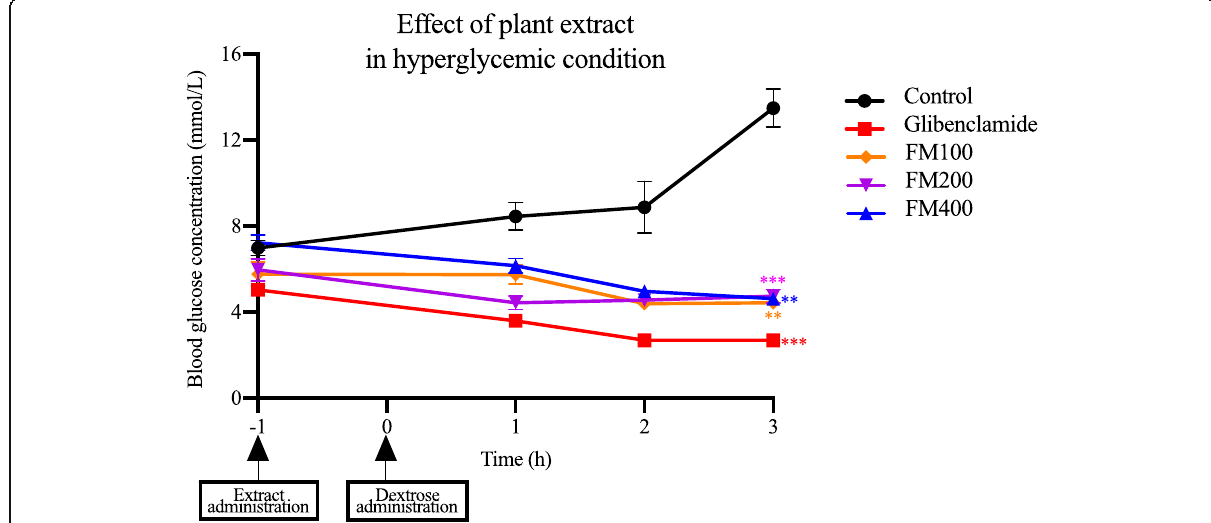
Fig. 1 Effect of methanol leaf extract of Fimbristylis miliacea on hyperglycemic condition. ‘ FM ’ stands for Fimbristylis miliacea and 100, 200 and 300 indicate doses in mg/kg. A probability level of 0.05 or less was accepted as significant; * p <0.05, ** p <0.01, *** p <0.001 vs. control i.e. distilled water